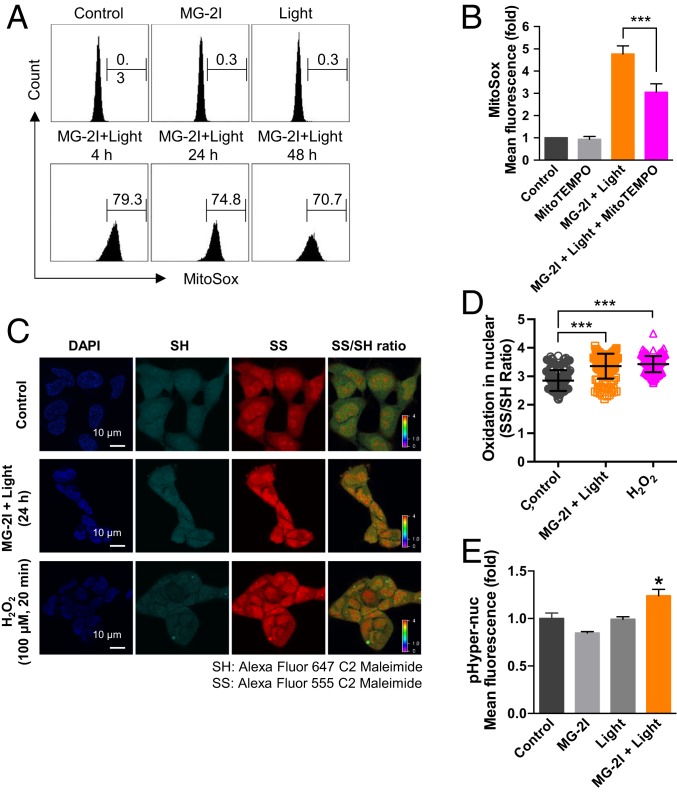
Singlet oxygen-induced mitochondrial dysfunction leads to a secondary wave generation of ROS. (A) Mitochondrial generation of ROS was determined by MitoSox at 4, 24, and 48 h after treatment of HEK293 Mito-FAP cells with MG-2I (50 nM), light (5 min), or light (5 min) in the presence of MG-2I (50 nM). (B) MitoTEMPO (100 nM) inhibited mitochondrial superoxide generation 4 h after treatment. ***P < 0.001. (C) Oxidation of protein SH group was evaluated by thiol oxidation immunocytochemistry 24 h after treatment with light (5 min) in the presence of MG-2I (50 nM). Treatment of 100 μM H2O2 for 20 min served as the positive control. Representative images are shown. (D) Quantification on the ratio of fluorescence intensity of Alexa Fluor 555/647 (SS/SH) in the nuclear region of the cells. Data are represented as mean ± SD. ***P < 0.001. (E) Detection of diffusion of H2O2 into nuclei by a fluorescent nuclear H2O2 sensor pHyper-nuc 24 h after treatment with light (5 min) in the presence of MG-2I (50 nM). Data are represented as mean ± SEM. *P < 0.05.